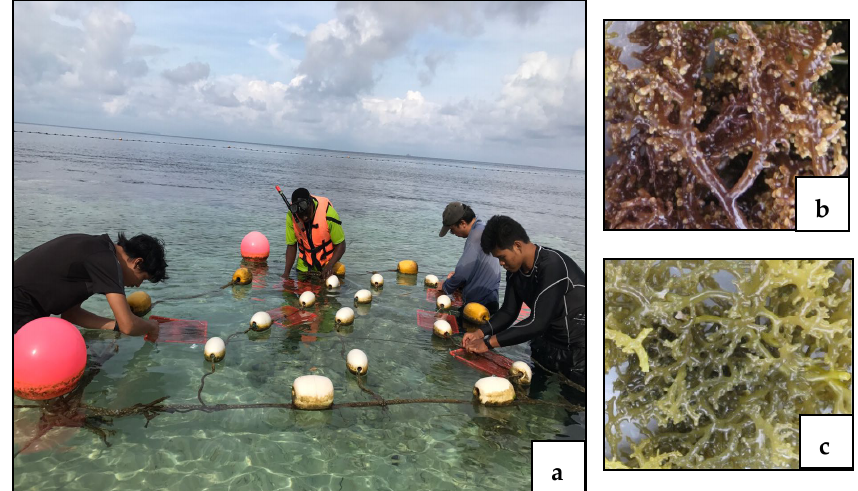
Figure 1. Basket system ( a ) of tropical eucheumatoids: Kappaphycus alvarezii ( b ) and Kappaphycusstriatus ( c ). Photo ( a ) was taken with farmer’s permission.